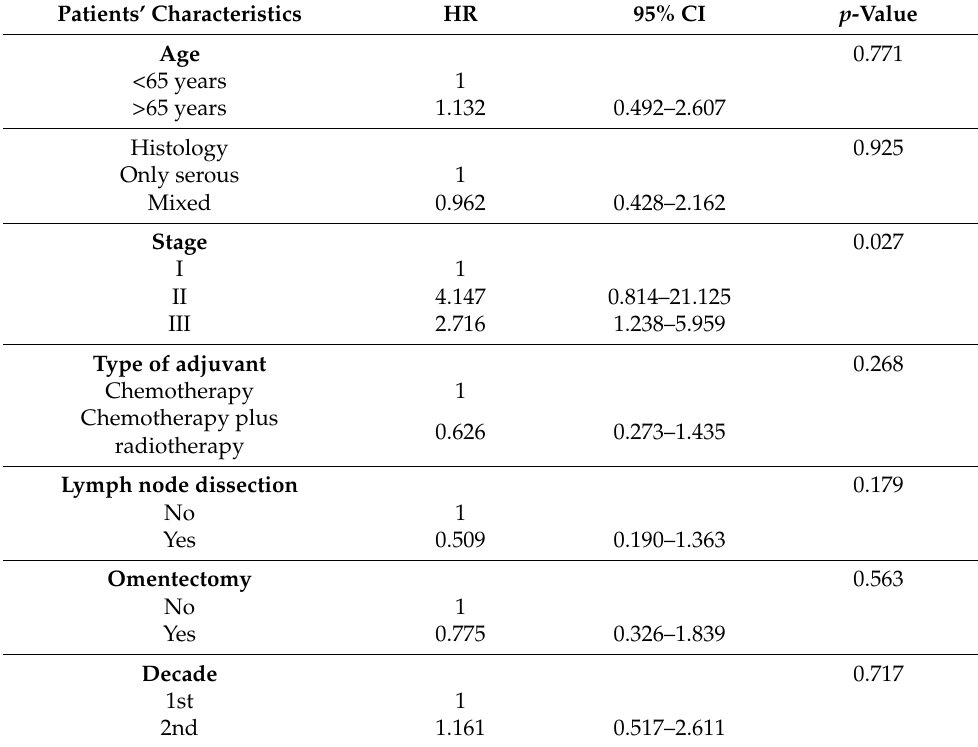
Table 2. Multivariant analysis of patients’ overall